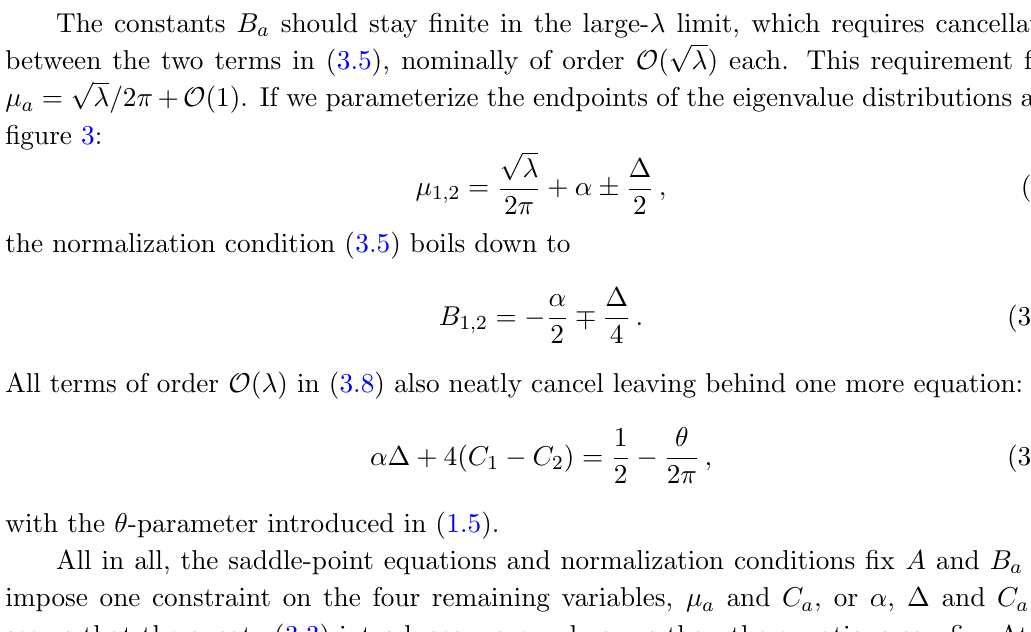
Figure 3 . The endpoint structure of the eigenvalue distribution: (cid:1) is the gap between (cid:22) 1 and (cid:22) 2 , while (cid:11) is the o(cid:11)set of the midpoint from the Gaussian-model prediction (cid:22) = (cid:12)gure